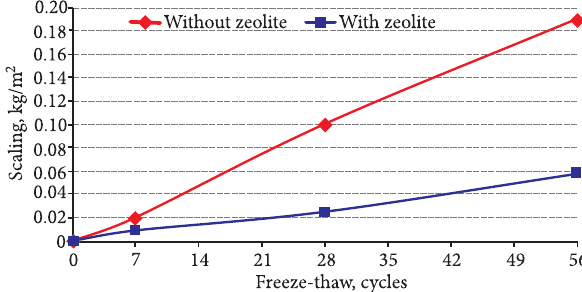
Fig. 10. Scaling of paving blocks after 56 freeze-thaw cycles according to CEN/TS 12390-9 CDF